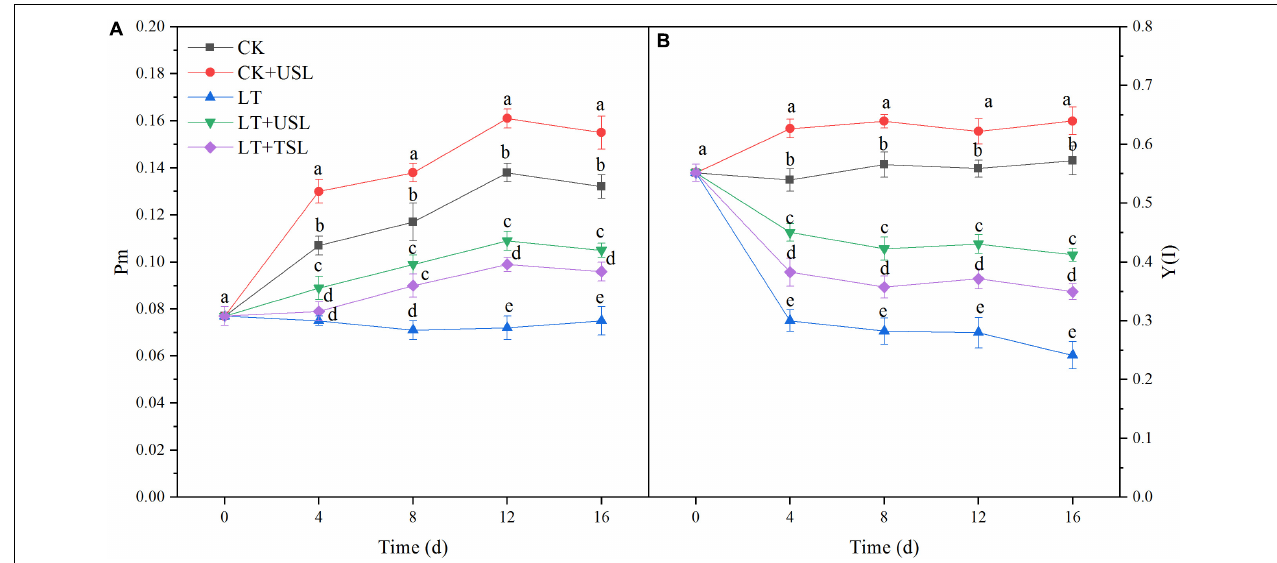
FIGURE 4 | Effects of USL on the PS I reaction center of tomato seedlings under LT stress. (A) Pm, the maximal P700 changes and (B) Y(I), the effective quantum yield of PS I.